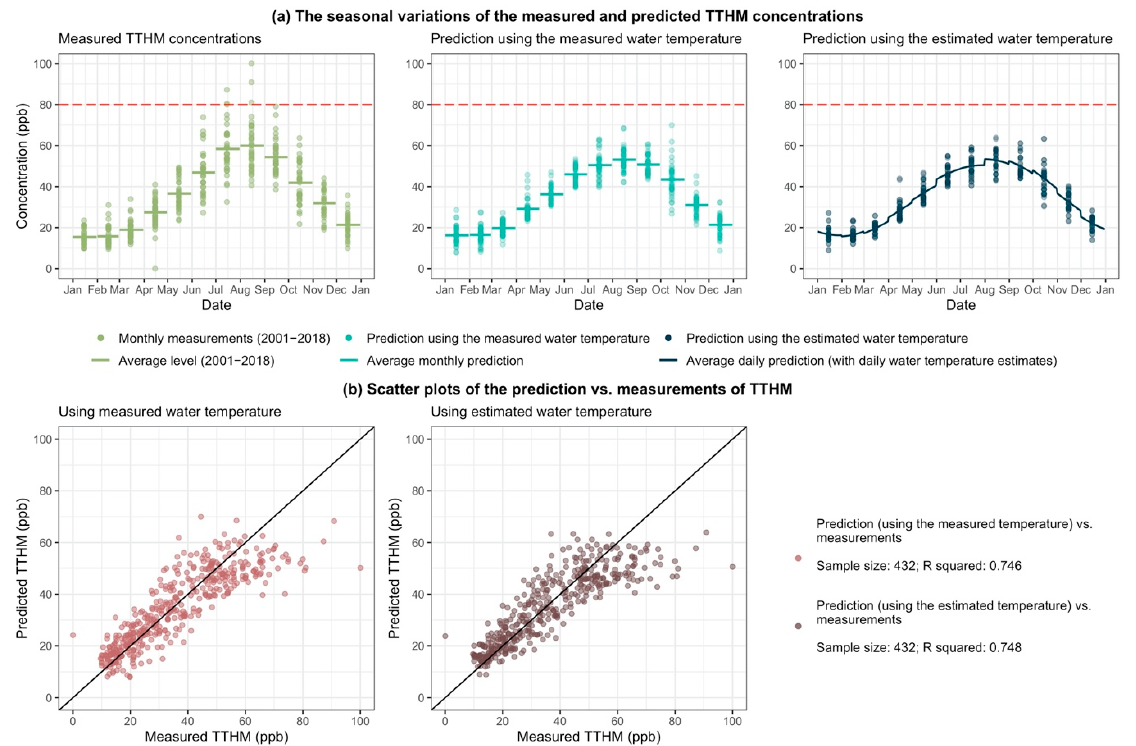
Figure 5. The measured and predicted TTHM concentrations for Washington D.C. with ( a ) seasonal variations of the monthly measured and predicted (using measured or estimated water temperature) TTHM concentrations for the same period 2001–2018; and ( b ) the comparisons between the predicted TTHM concentrations (with the use of measured or estimated water temperature) and the measured monthly average TTHM concentrations. The predictions were obtained using the empirical model presented as Equation (4) of Table 1. The measurements of TTHM concentrations were obtained from the treated water (measurements of TTHM in the DWDS are limited). As monthly measurements of other required parameter values were kept the same and used for the daily calculation in the rightmost graph of part ( a ), the daily estimates exhibit sudden shifts in different months. The red dashed lines in part ( a ) present the regulated level (80 ppb) for TTHM concentrations